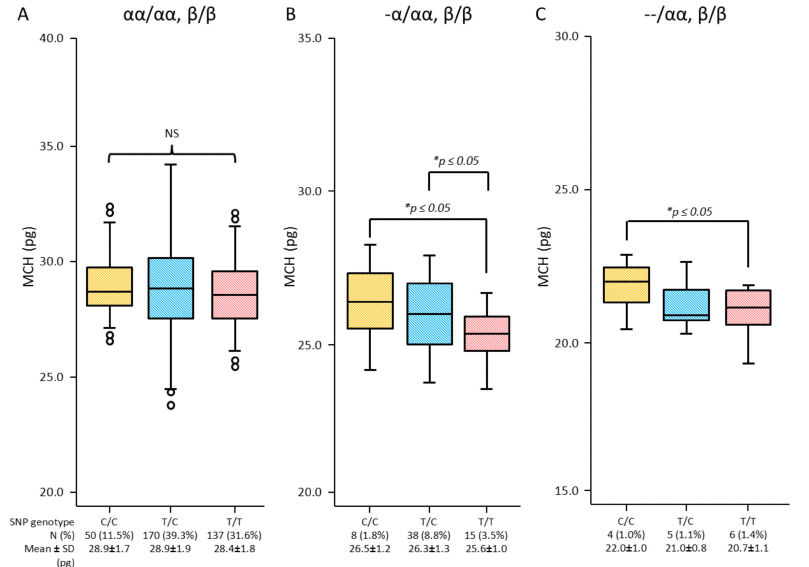
Figure 3. Characteristics of MCH among SNP rs855791 genotypes (C/C, T/C, T/T) of TMPRSS6 in the population of normal α -globin gene ( αα / αα ) ( A ), α + -thal (- α / αα ) ( B ) and α o -thal (–/ αα ) ( C ) (*significant difference at p -value ≤ 0.05 from independent t -test; NS, non-statistical significance at p >